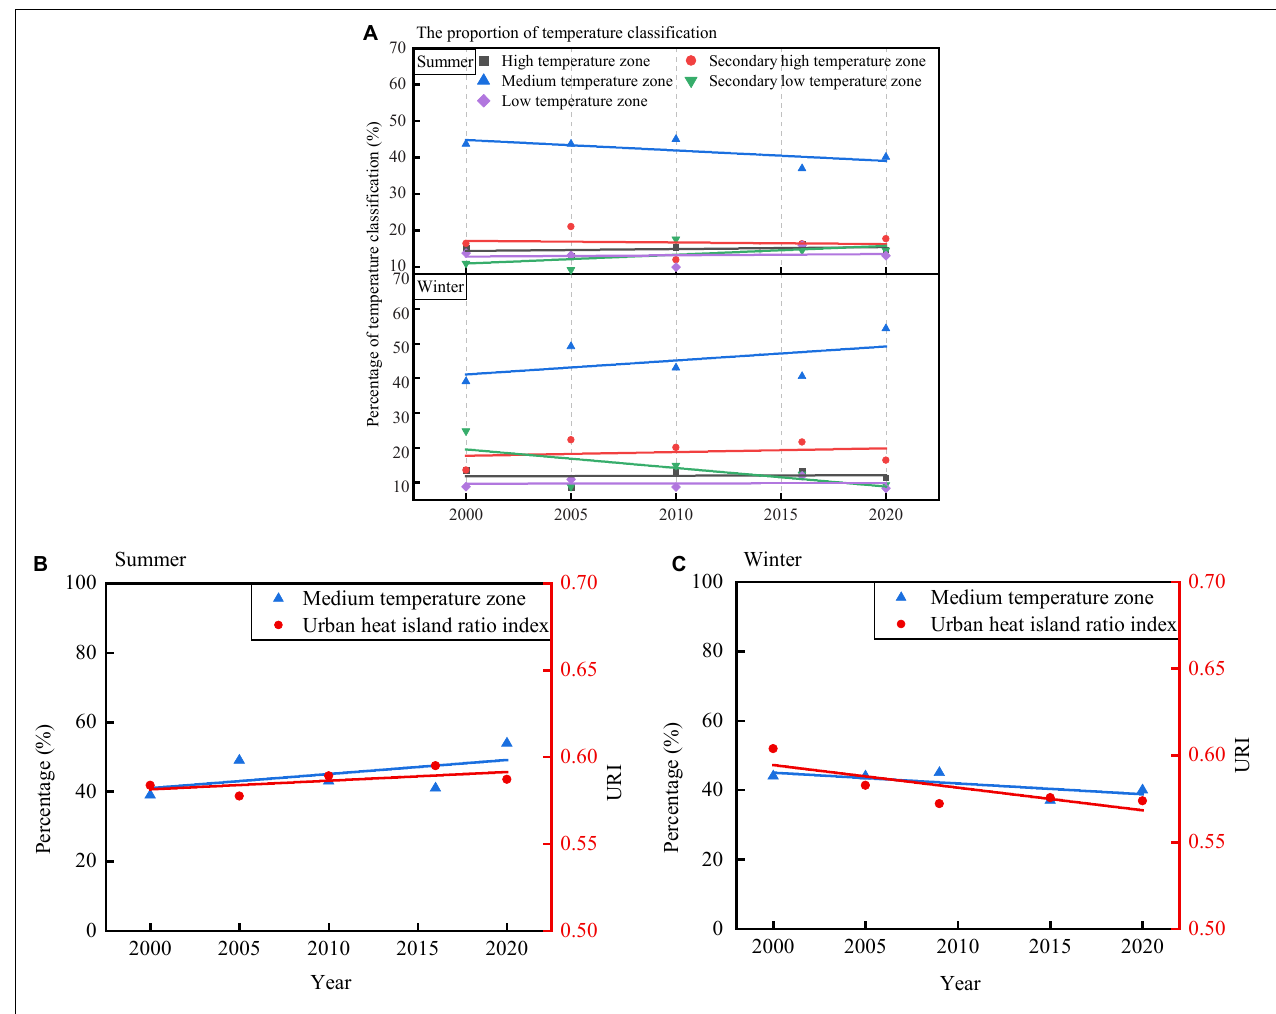
FIGURE 8 | Temporal change of urban heat island ratio index (A) the proportion change of different classificaiton in winter and summer from 2000to 2020, (B) the medium temperature proportion and URI in summer from 2000to 2020, and (C) the medium temperature proportion and URI in winter from 2000to 2020.